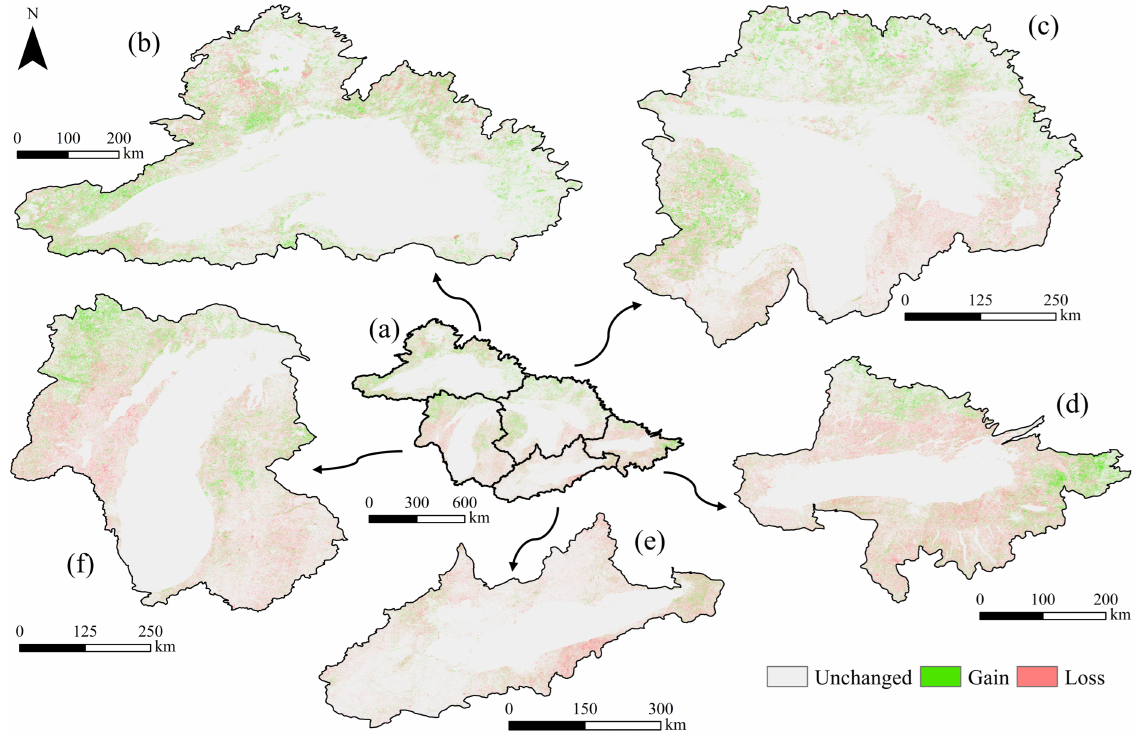
Figure 14. Gain and Loss map of wetlands of the ( a ) Great Lakes basin and ( b – f ) its subbasins (i.e., Lake Superior, Lake Huron, Lake Ontario, Lake Erie, and Lake Michigan, respectively) in the past four